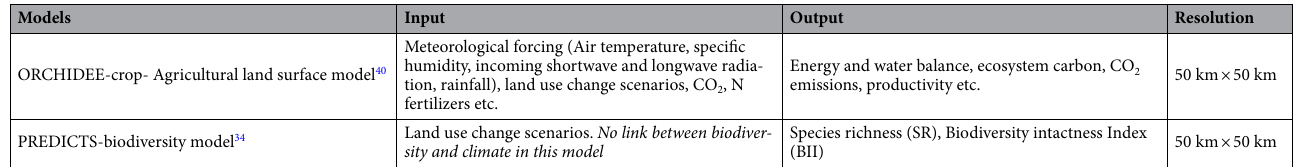
Table 2. Overview of the ORCHIDEE-crop and PREDICTS models input and output.